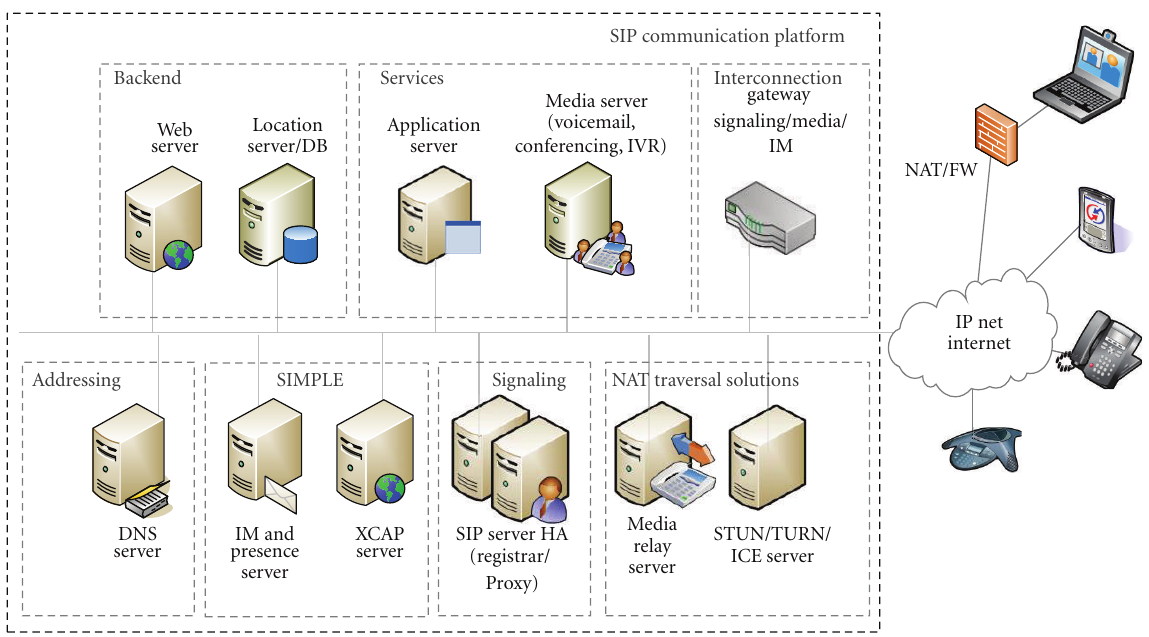
Figure 6: Identified platform